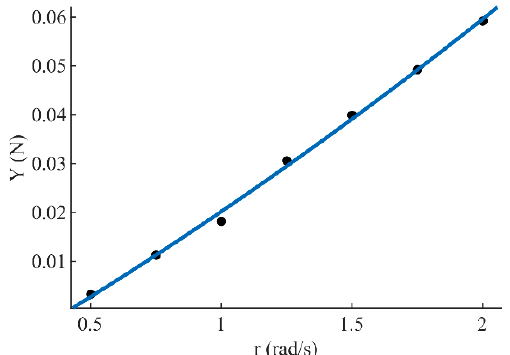
Figure 9. Fitted curve of vertical force Y and angular velocity r.